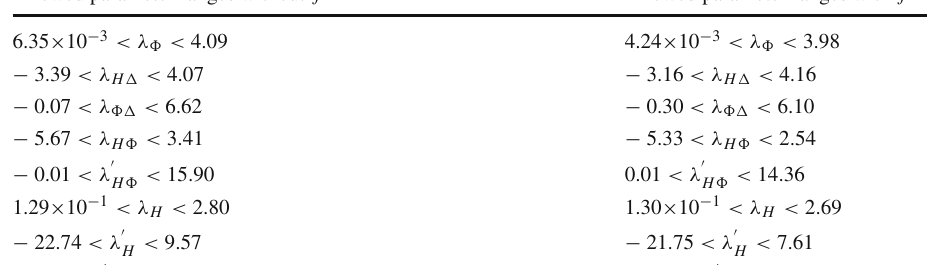
Allowed parameter ranges without f H Allowed parameter ranges with f H parameter space after DM constraints 6.35 × 10 − 3 < λ (cid:3) < 4.09